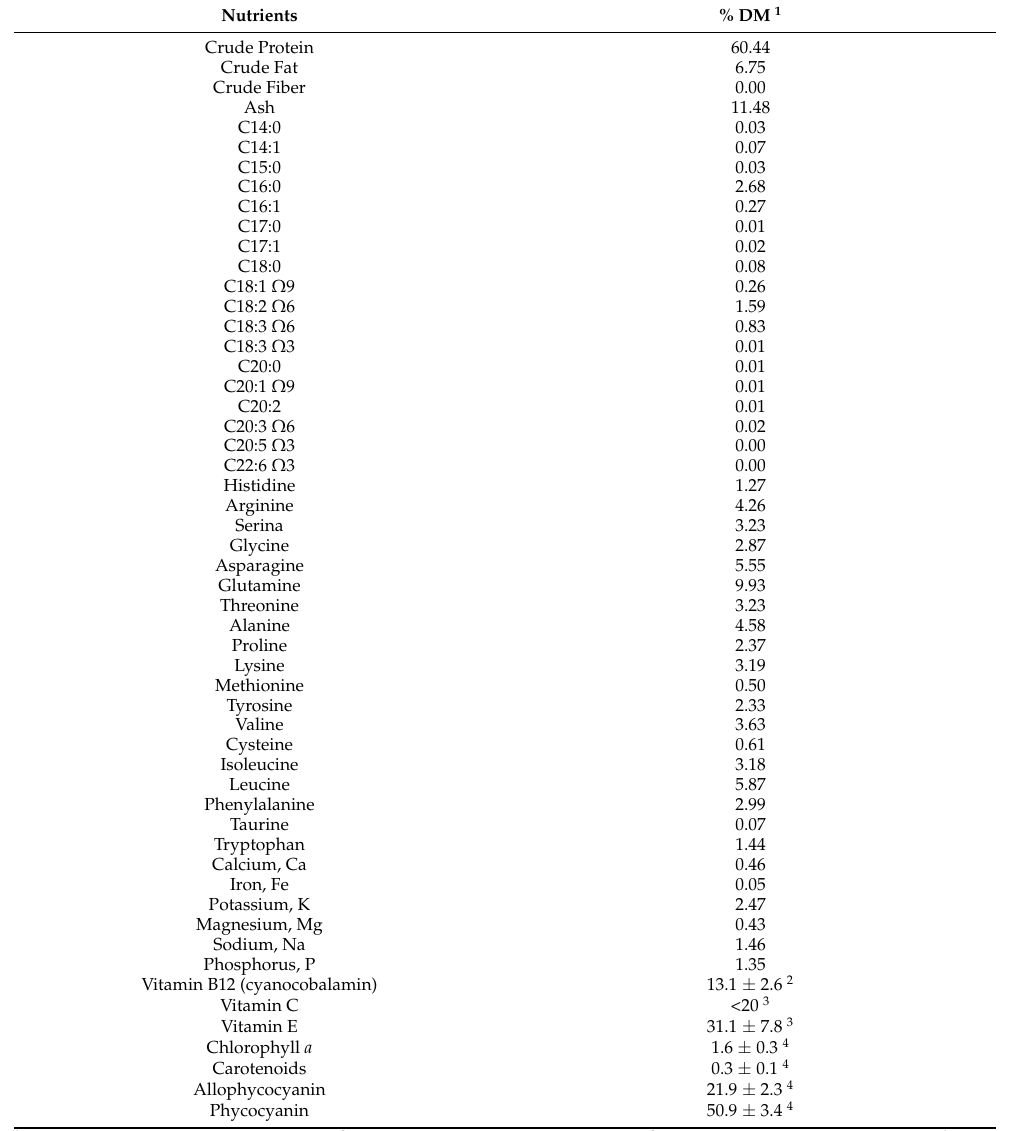
Table 2. Nutritional composition of the Spirulina tablets used in the trial, including proximate analysis, fatty acid profile, amino acid profile, mineral and vitamin composition, and pigment